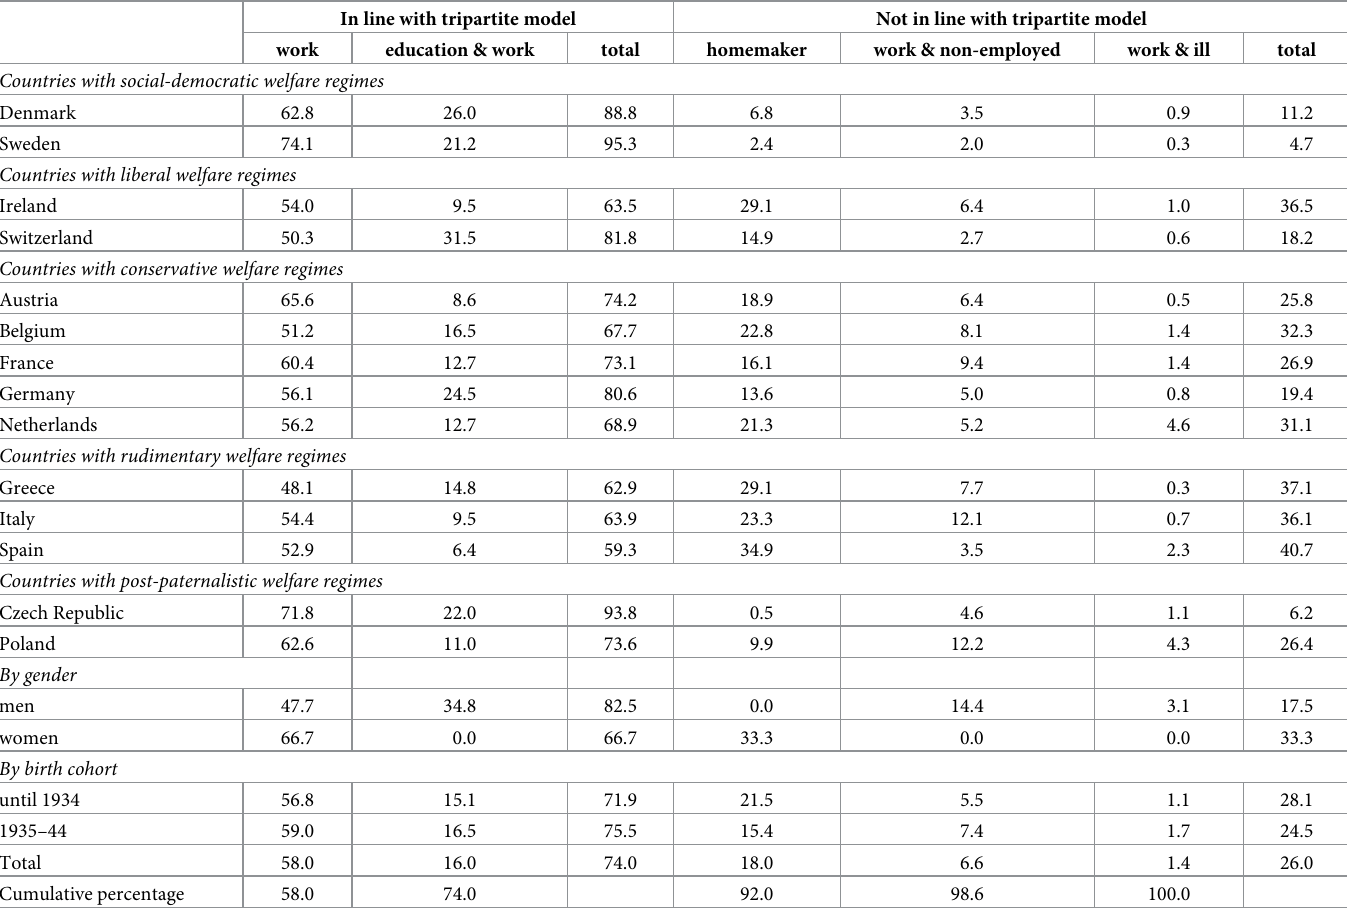
Table 4. Working age life-course clusters by country, gender and cohort (in percent). In line with tripartite